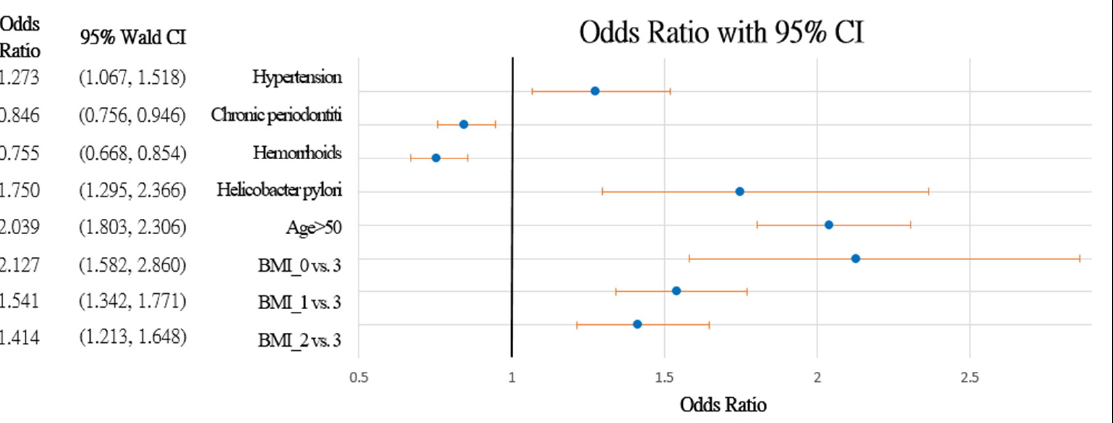
Figure 3. Forest chart of colorectal polyps’ risk factors in male patients. Underweight = 0, normal = 1, overweight = 2, and obesity = 3.